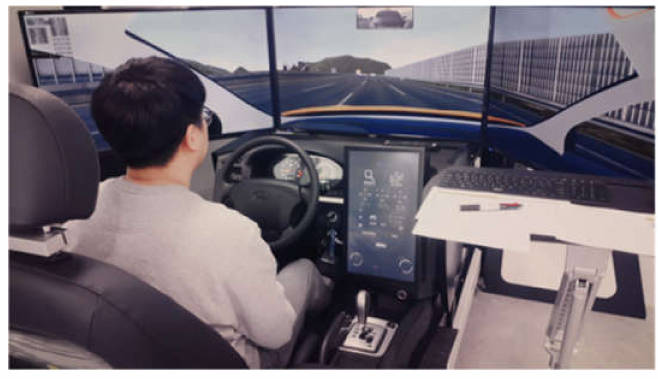
Figure 2. Driving simulator employed in